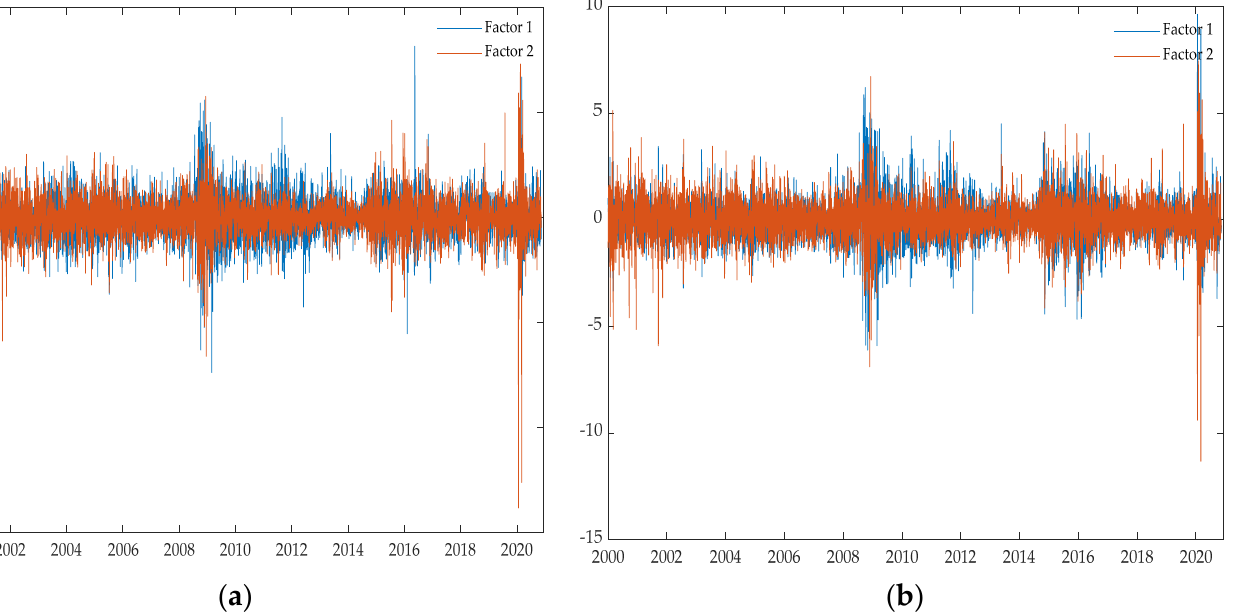
Figure 2. Dynamic variation characteristics of common factors. ( a ) Oil-importing countries. ( b ) Oil-exporting countries.